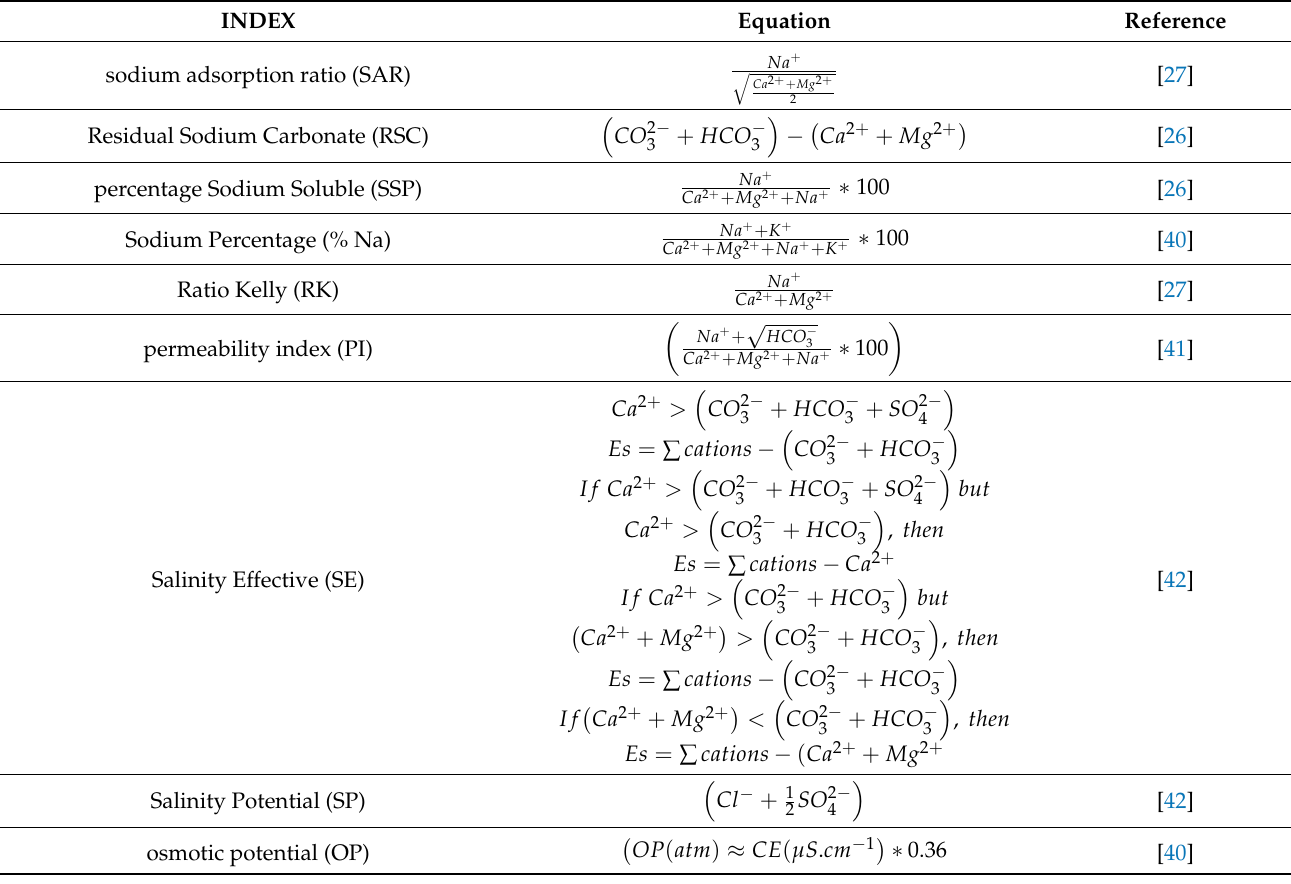
Table 1. Main equations to obtain the irrigation